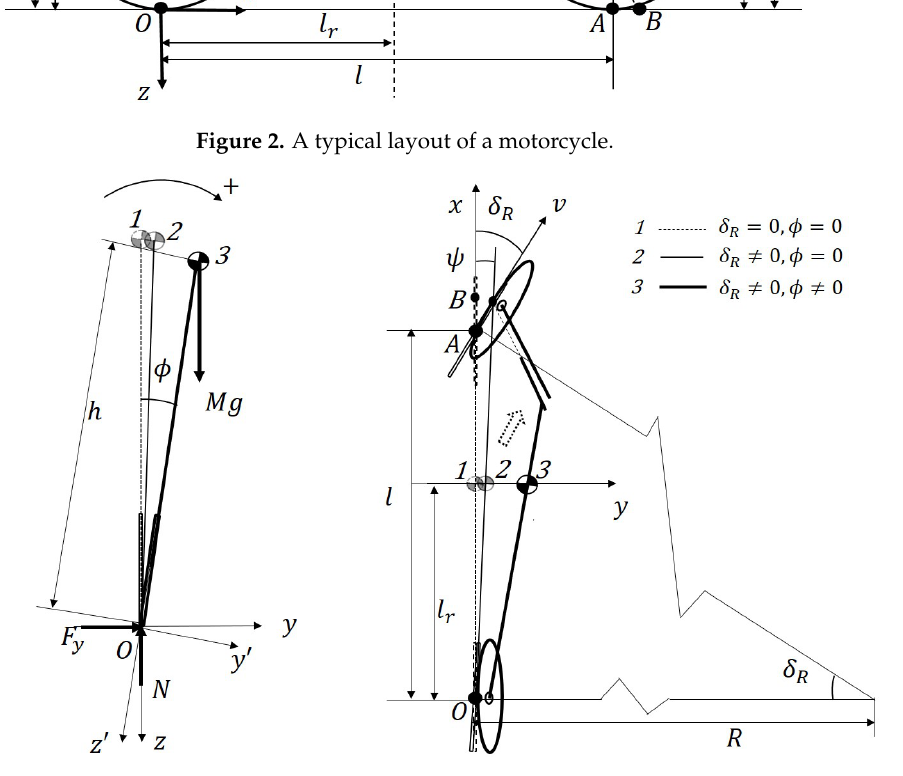
Figure 3. Schematic of linear model of motorcycle showing its different